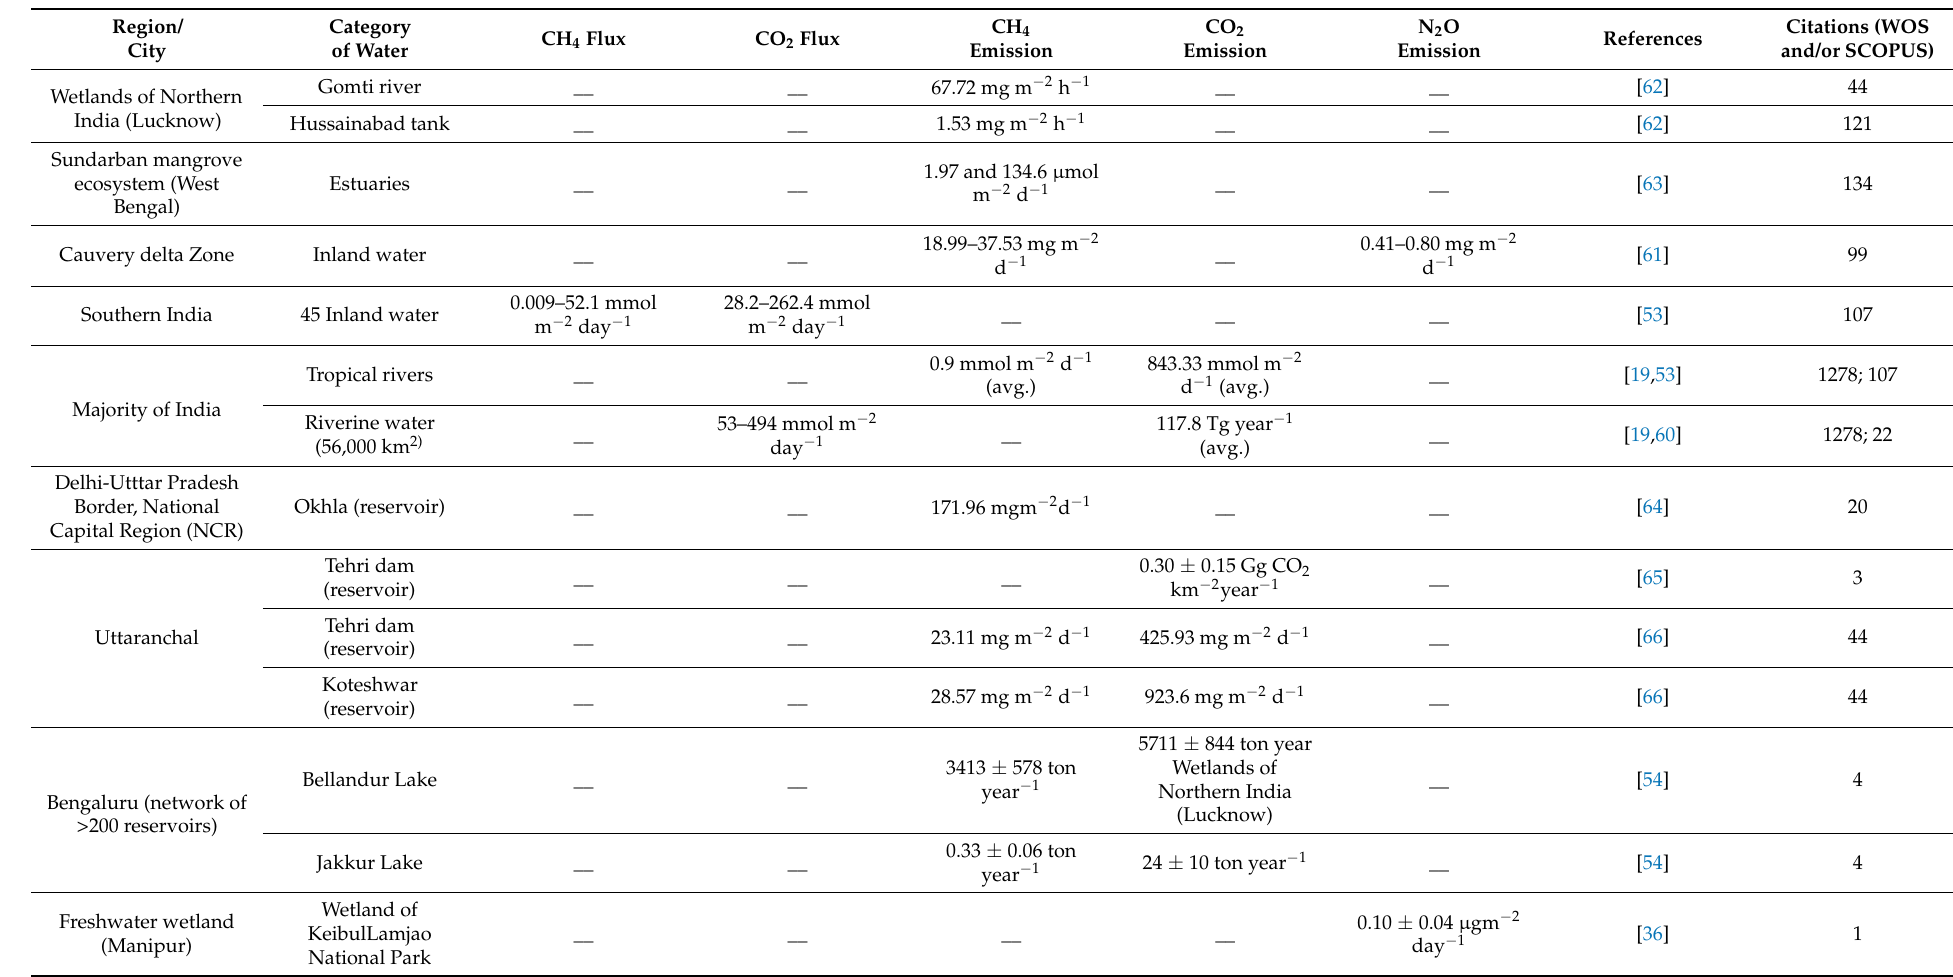
Table 4. Accountability of GHGs emissions and fluxes from Indian freshwater